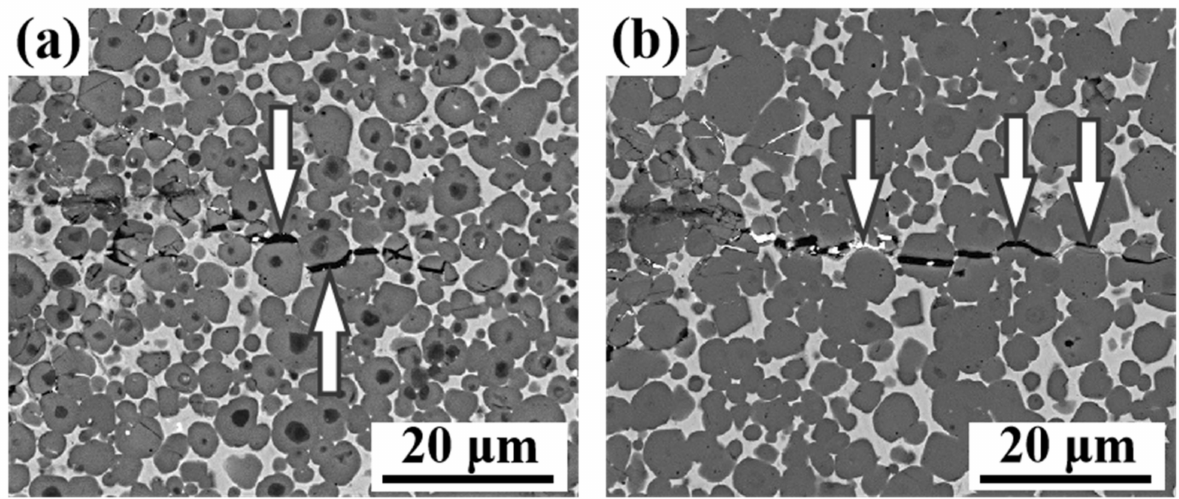
Figure 12. Crack growth diagram: ( a ) (Ti, W) C-Ni and ( b ) (Ti, Mo)